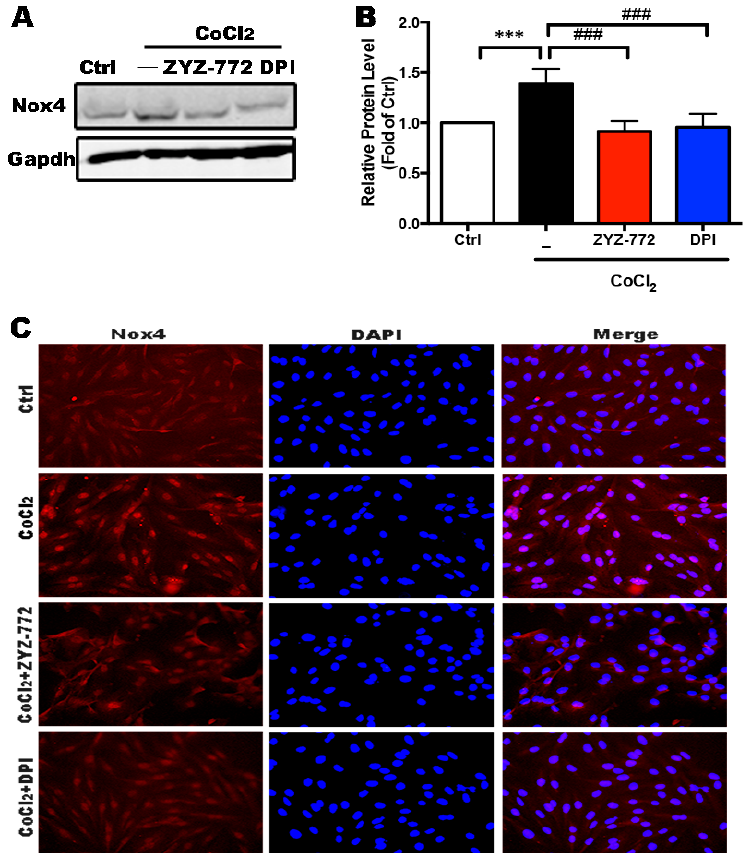
Figure 2. ZYZ-772 attenuated Nox4 expression induced by CoCl 2 . ( A ) Protein level of Nox4 was determined by Western blot. GAPDH was used as loading control; ( B ) statistical analysis of relative protein level of Nox4; and ( C ) Nox4 expression was displayed by immunofluorescence. Representative photomicrographs showing Nox4 expression (red) and DAPI staining (blue) indicates the nuclei. *** p < 0.001 versus control group. ### p < 0.001 versus vehicle group. Error bars represent the data obtained from the experiments repeated three times or more.